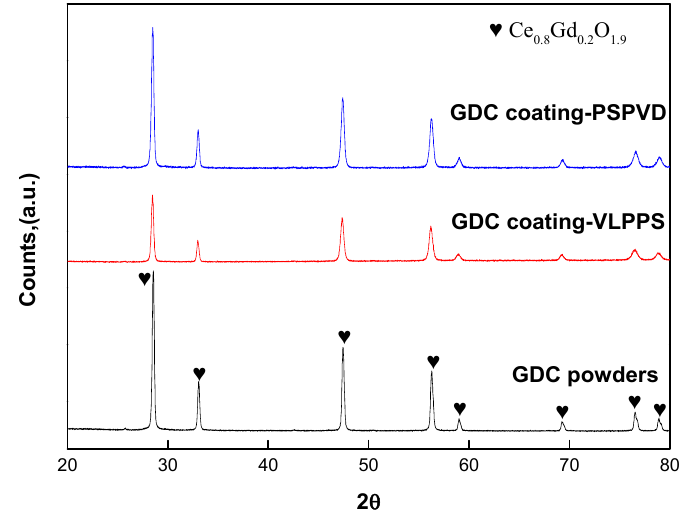
Figure 4. XRD patterns of the initial GDC powder and as-sprayed coatings.